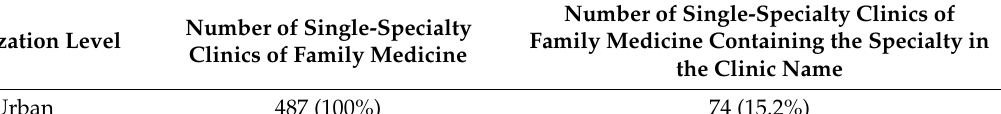
Table 1. Single-specialty clinic names including a term for “family medicine” at di ff erent urbanization